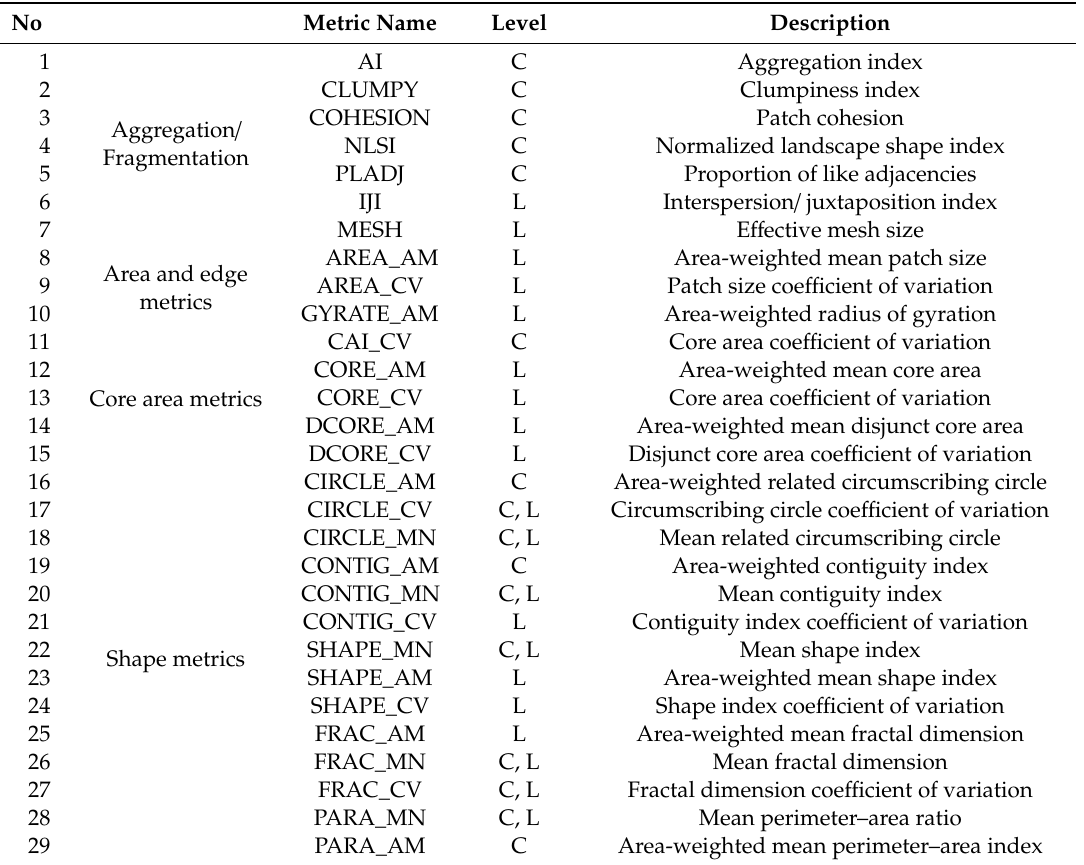
Table 3. Set of high representative metrics for analyzing multi-temporal forest types structure at class and landscape level in the study